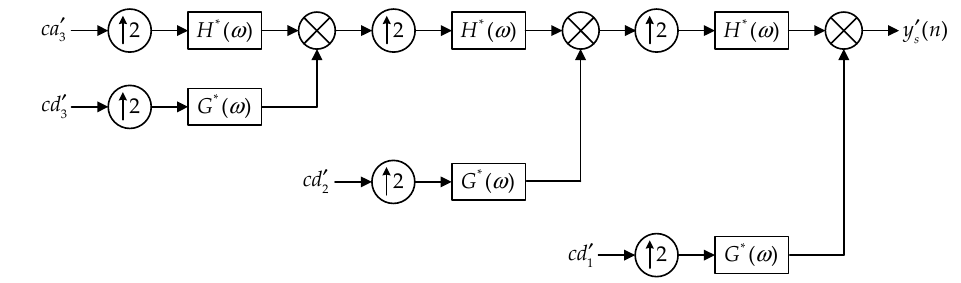
Figure 4. Scheme of wavelet reconstruction.